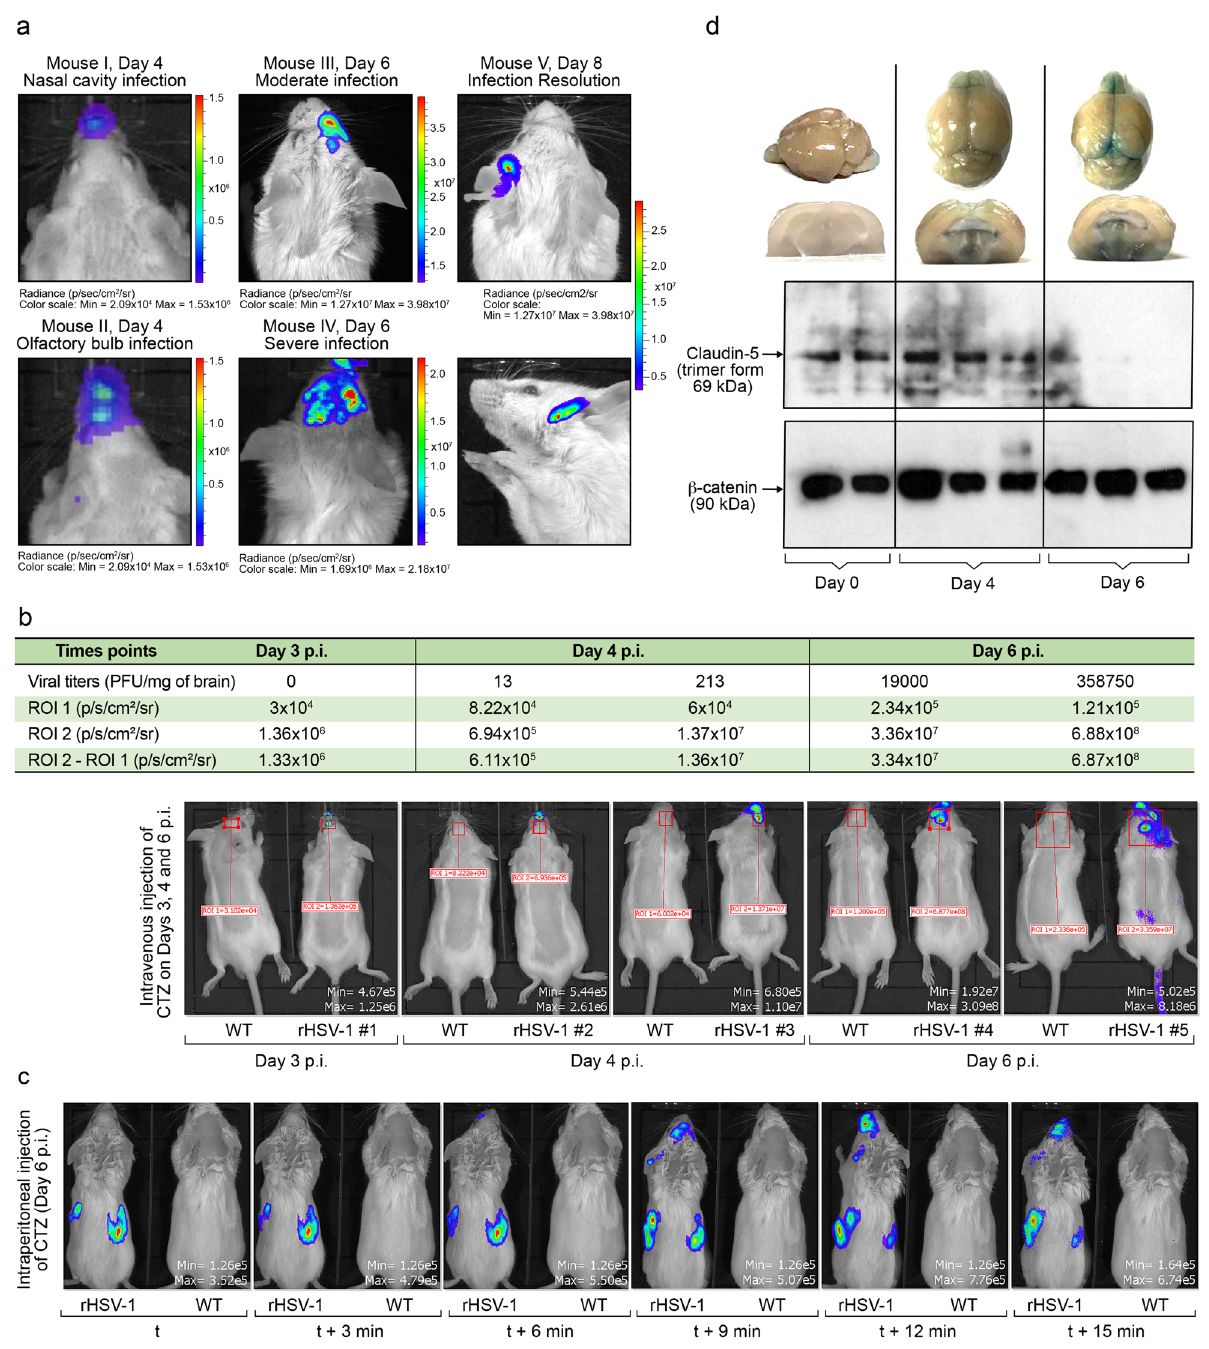
Figure 7. Study of viral dissemination in the CNS and viral titer estimation in herpes simplex virus encephalitis (HSE) by bioluminescent imaging (BLI). ( a ) Representative BLI images of early (Mouse I and Mouse II, Day 4), moderate (Mouse III, Day 6) and severe (Mouse IV, Day 6) HSE are shown at different time points. Two images acquired from different angles (both images captured from the same “Mouse V, Day 8”) allowed a better anatomical localization of infected areas. ( b ) A bioluminescence imaging series of representative mice infected with 1 500 PFU of WT HSV-1 (mice on the left side) or rHSV-1 (mice on the right side) on days 3, 4 and 6 p.i. The bioluminescent signal is expressed in average radiance (p/s/cm 2 /sr). Animals infected with rHSV-1 were sacrificed and brains were removed to measure viral titers by plaque assay. The above table shows ROI-1 (negative control area, mouse infected with WT HSV-1 strain H25), ROI-2 (bioluminescent signal in the CNS, mouse infected with rHSV-1) radiance values (p/s/cm2/sr), ROI-2–ROI-1 (normalized bioluminescent signal) and viral titers in brains for each rHSV-1 infected-mouse ( c ) Time-course imaging of rHSV-1-infected mice to evaluate blood–brain barrier (BBB). Following intraperitoneal CTZ injection, mice inoculated with 1 500 PFU of rHSV-1 were imaged every 3 min on day 6 post-infection. ( d ) BBB permeability is increased in rHSV-1-infected brains. Whole brain photos show that olfactory bulbs (on days 4 and 6 p.i.) and superior colliculus (on day 6) were intensely stained with extravasated Evans Blue dye (EBD). Coronal sections of whole brains showed EBD accumulation in thalamus and periventricular nucleus in hypothalamus of brains on days 4 and 6 p.i. (above). Western blots for claudin-5 were performed with whole brain extracts from rHSV-1-infected mouse brains. Trimer forms of Claudin-5 (69 kDa) expression were highly reduced on day 6